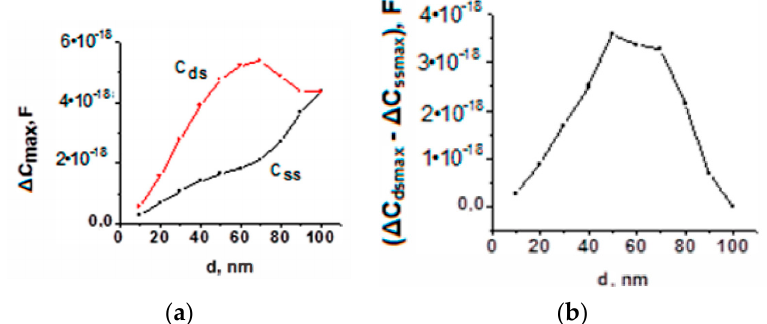
Figure 5. Dependence of the amplitude of changes in lateral capacitances Δ Cdbmax and Δ Csbmax ( a ) and their difference ( b ) on linear size of the embedded charge at the drain end of the gate oxide.